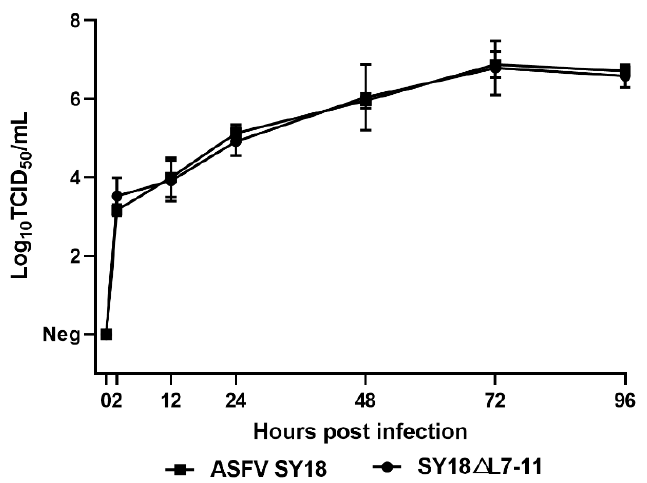
Figure 2. In vitro growth characteristics of SY18 (cid:52) L7-11 and parental ASFV SY18. Primary swine macrophages were infected (multiplicity of infection (MOI) = 0.1) with either SY18 (cid:52) L7-11 or parental ASFV SY18. Samples were taken from three independent experiments at the indicated times postin- fection and titrated. Data represent means and standard deviations. Sensitivity of the methodology for this detection is ≥ 1.625 log 10 TCID 50 /mL. Neg: